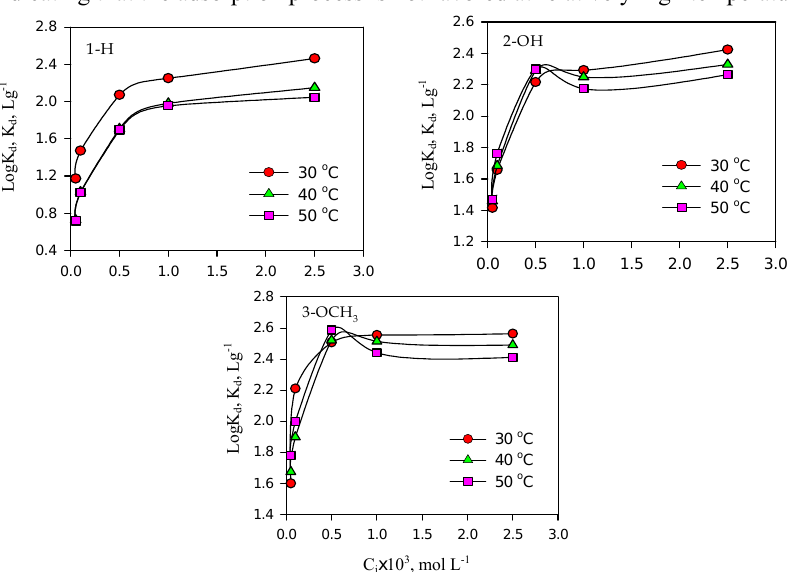
) with the initial concentration of the d